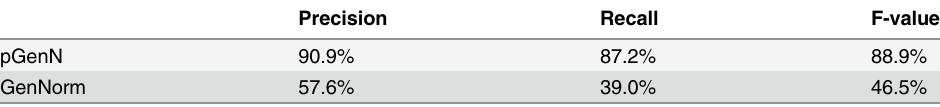
Table 6. Performance of pGenN & GenNorm on in-house plant